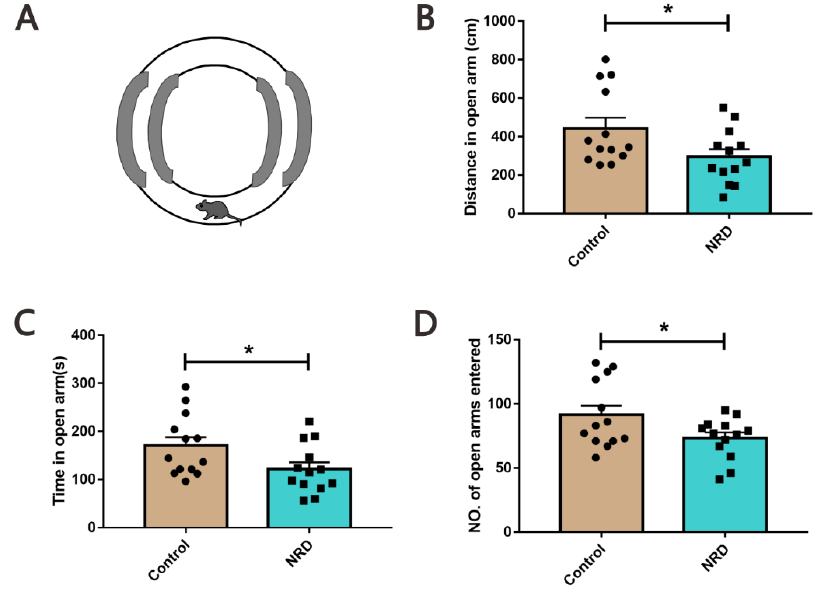
Figure 3. Anxiety-like behavior in NRD mice. ( A ) Diagram of the O-maze apparatus. ( B – D ) Perfor- mances of the control and NRD mice regarding the distance covered in open arms ( B ), time in open arms ( C ), and number of open arms entered ( D ). * p < 0.05 as determined by unpaired Student’s t - test. Data are expressed as the means ± SEMs. n (control) = 13, n (NRD) = 13.